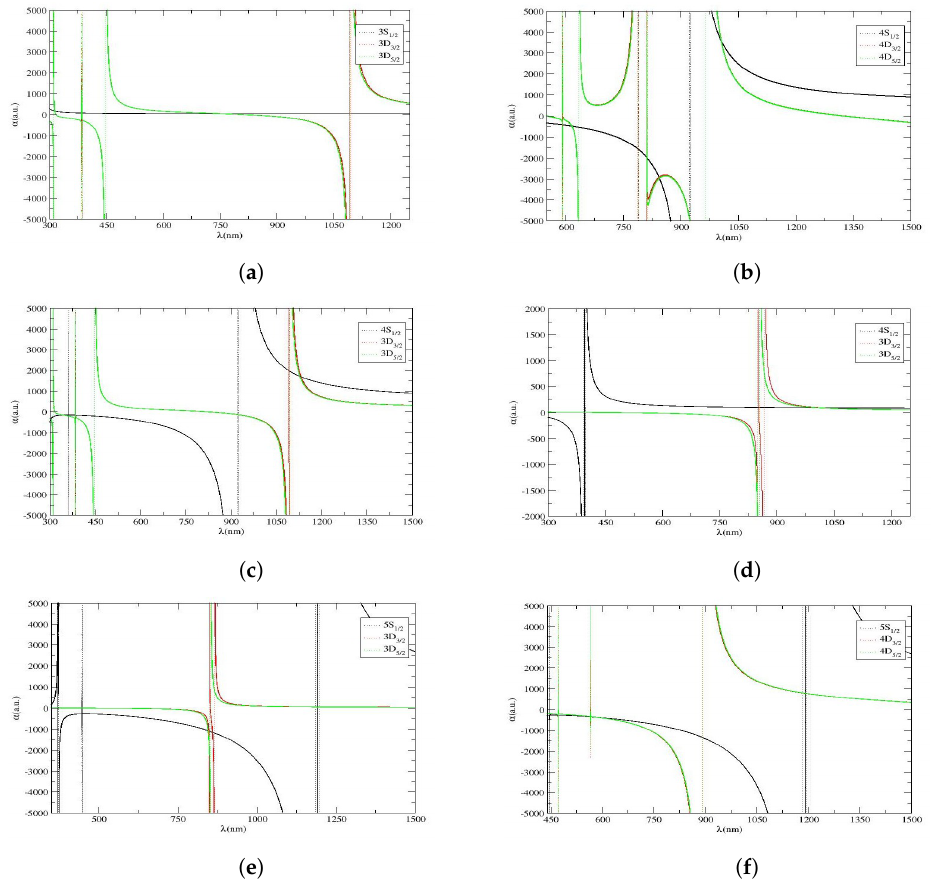
Figure 2. α v/s λ plots for various transitions in Mg + and Ca + ions. ( a ) α v/s λ plot for 3 S 1/2 − 3 D 3/2,5/2 transition in Mg + ion. ( b ) α v/s λ plot for 4 S 1/2 − 4 D 3/2,5/2 transition in Mg + ion. ( c ) α v/s λ plot for 4 S 1/2 − 3 D 3/2,5/2 transition in Mg + ion. ( d ) α v/s λ plot for 4 S 1/2 − 3 D 3/2,5/2 transition in Ca + ion. ( e ) α v/s λ plot for 5 S 1/2 − 3 D 3/2,5/2 transition in Ca + ion. ( f ) α v/s λ plot for 5 S 1/2 − 4 D 3/2,5/2 transition in Ca +